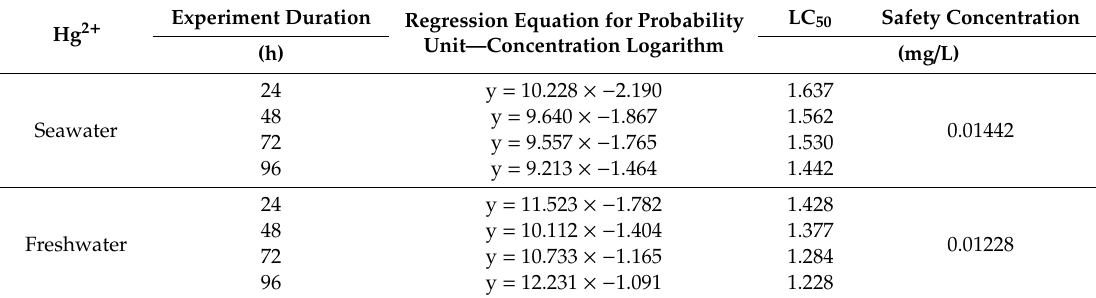
Table 2. Median lethal and safety concentrations of divalent mercury ion to Anguilla japonica . Experiment Duration Regression Equation for Hg 2 +